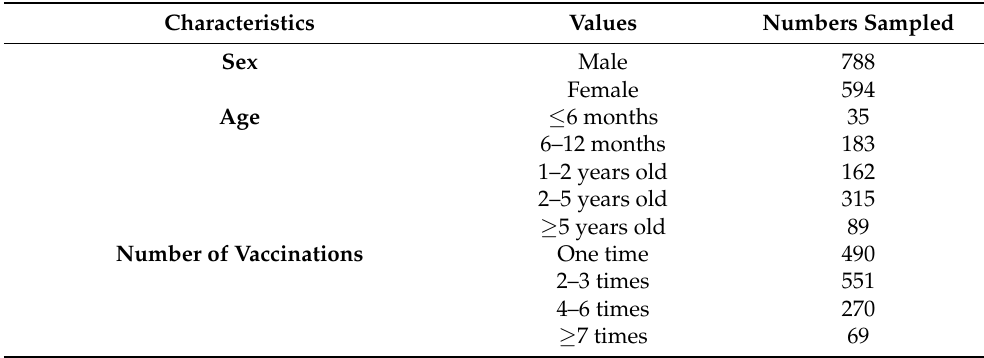
Table 3. The different background information of the serum samples corresponds to the number of